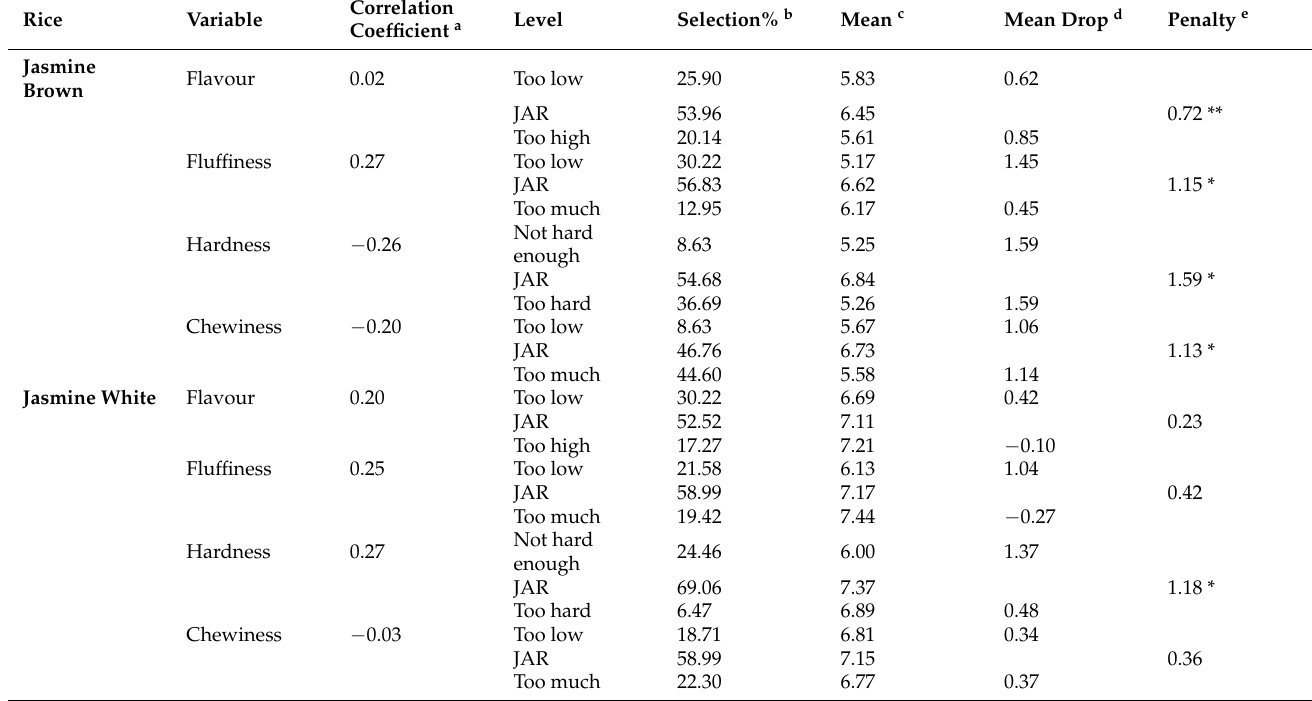
Table 8. The Penalty analysis and JAR variables (after tasting) for Jasmine brown and Jasmine white rice.